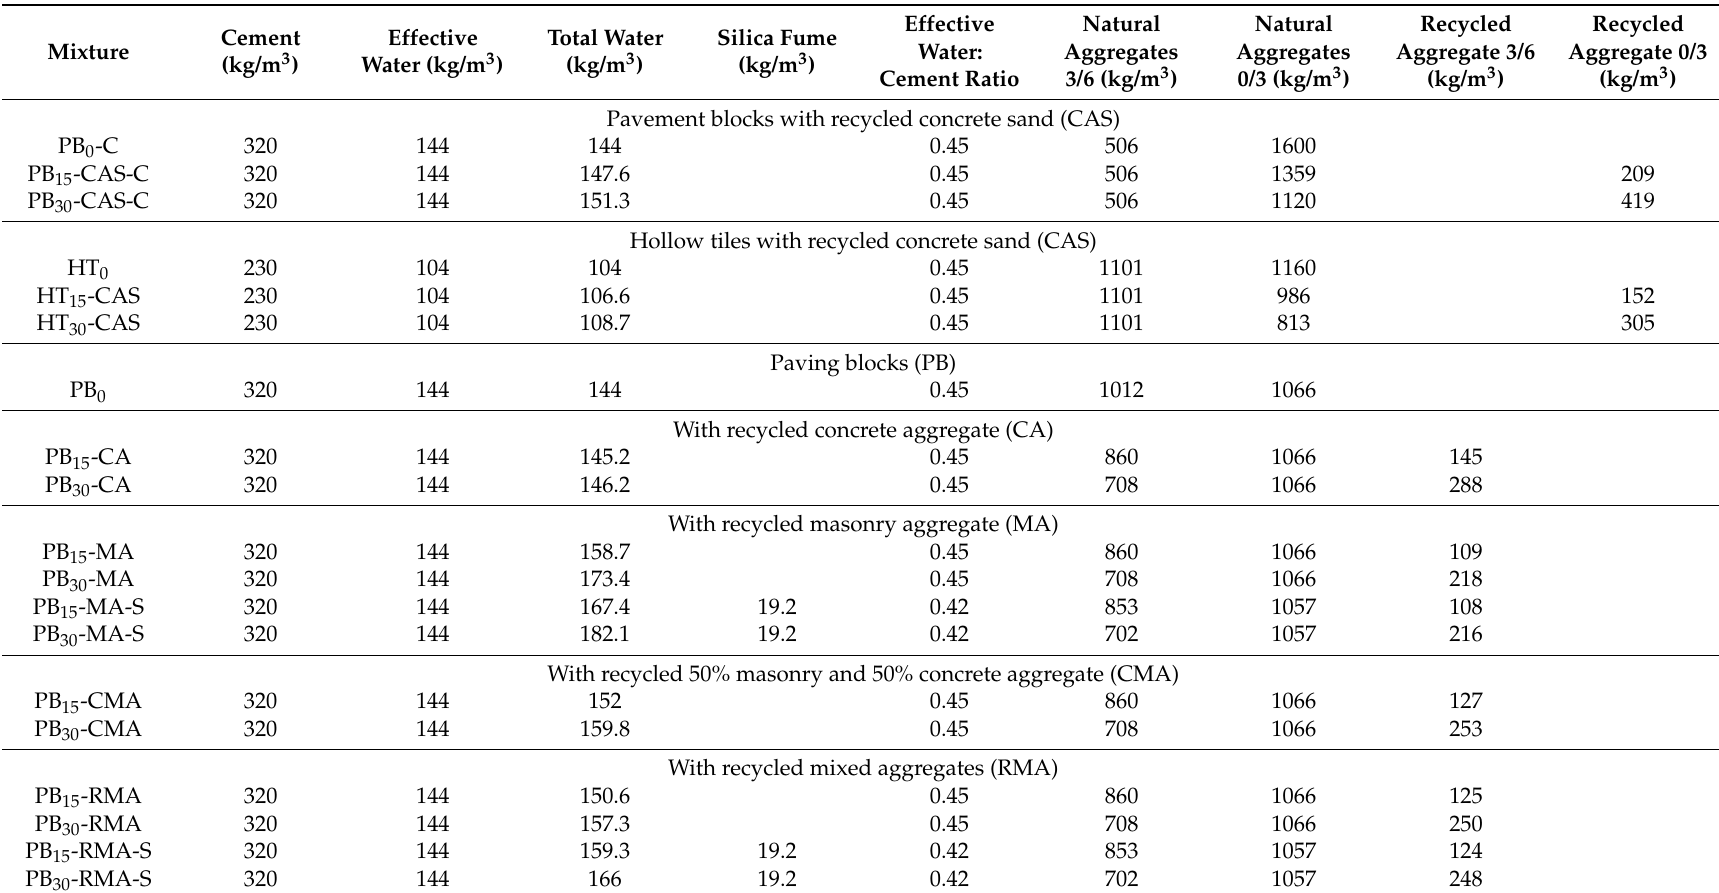
Table 5. Dosages used for each